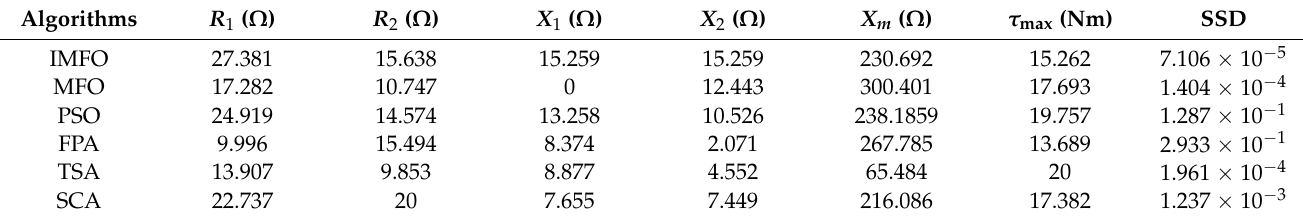
Table 3. Optimized value of all parameters.